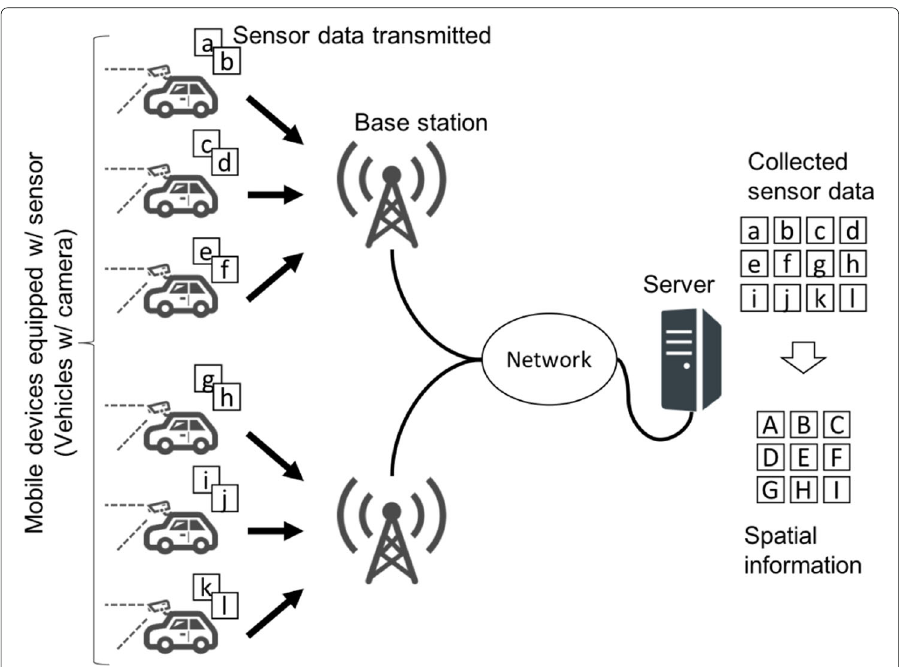
Fig. 1 System for predicting spatial information in real